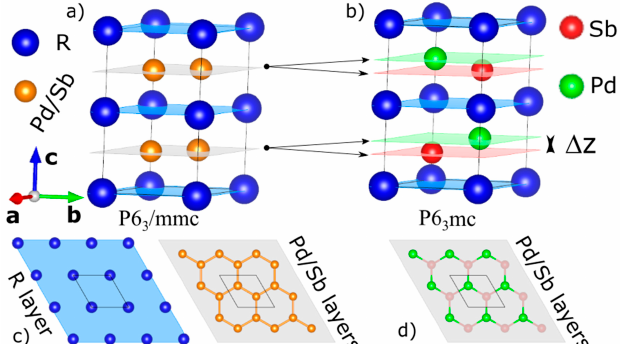
Figure 1. Crystal structures for RPdSb, R-La, and Ce: ( a ) crystal structure associated with space group P6 3 /mmc (model 1), CaIn 2 -type structure; ( b ) crystal structure obtained from a joint refinement of the neutron and X-ray single-crystal data associated with space group P6 3 mc (model 3), ZrBeSi-type structure; ( c , d ) schematic representation of the R, Pd, and Sb alternating layers; the black double arrows show the splitting of the disordered Pd/Sb layers into two ordered Pd and Sb layers by an amount ∆ z; blue, grey, red, and green sheets show schematically the atomic layers.